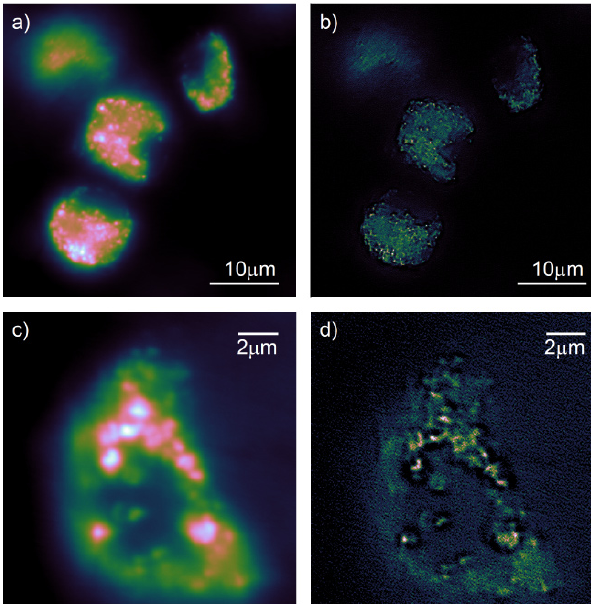
Figure 3) Figure-Macrophages.png (The file used to generate Figure 3, in PNG format) Figure 3)